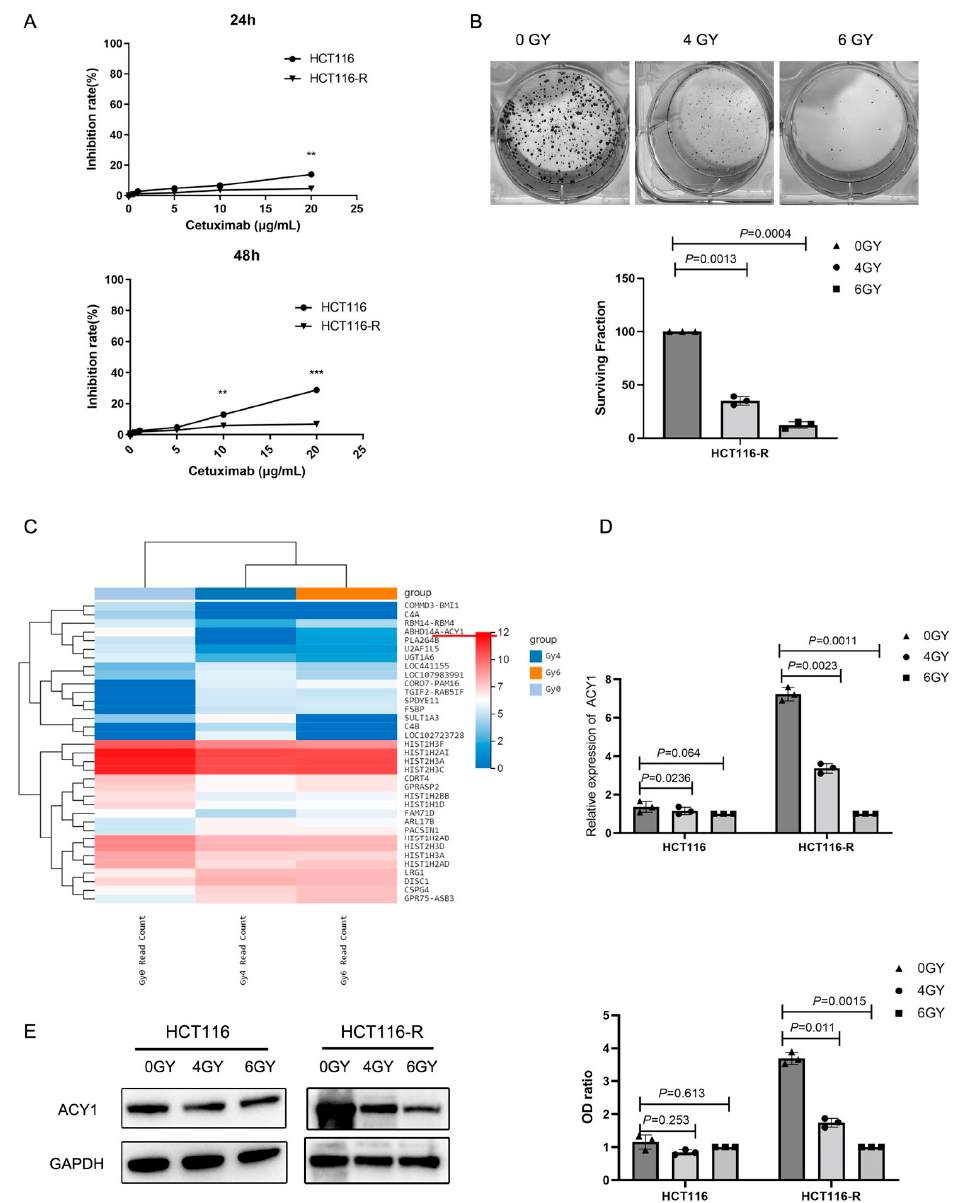
Figure 1. Irradiation treatment significantly inhibits the proliferation and reduces the expression of ACY1 in cetuximab-resistant CRC cells. ( A ) The sensitivity of a panel of the CRC cell line HCT116 and the cetuximab-resistant CRC cell line HCT116-R to cetuximab was assessed by CCK8 assays. CRC cells were incubated with graded concentrations (0–20 µ g/mL) of cetuximab for 24 h and 48 h. ( B ) A colony formation assay was performed in HCT116-R cells after exposure to graded doses of irradiation (0, 4, and 6 Gy). The surviving fraction of HCT116-R cells was determined at least three times, and the data are presented as the mean ± SD. ( C ) The heatmap from the hierarchical clustering of 35 mRNA expression patterns in HCT116-R cells treated with 0, 4, and 6 Gy irradiation is shown. ( D ) The expression of ACY1 was examined by qRT-PCR in HCT116 and HCT116-R cells treated with 0, 4, and 6 Gy irradiation. The experiment was repeated at least three times, and the data are presented as the mean ± SD. ( E ) The expression of ACY1 in HCT116 and HCT116-R cells treated with 0, 4, and 6 Gy irradiation was examined by Western blotting. The experiment was repeated at least three times, and the data are presented as the mean ± SD. ** p < 0.01, and *** p <